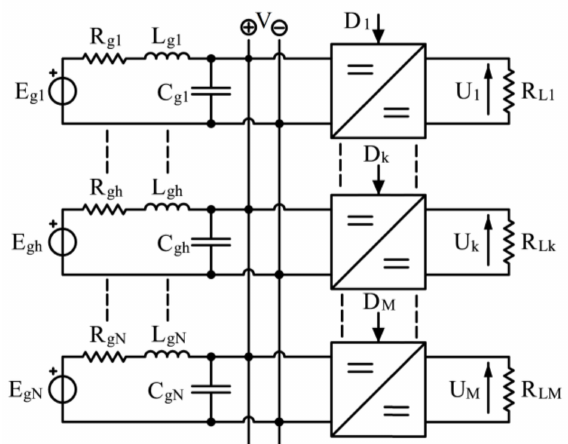
Figure 2. Microgrid simplification under modeling